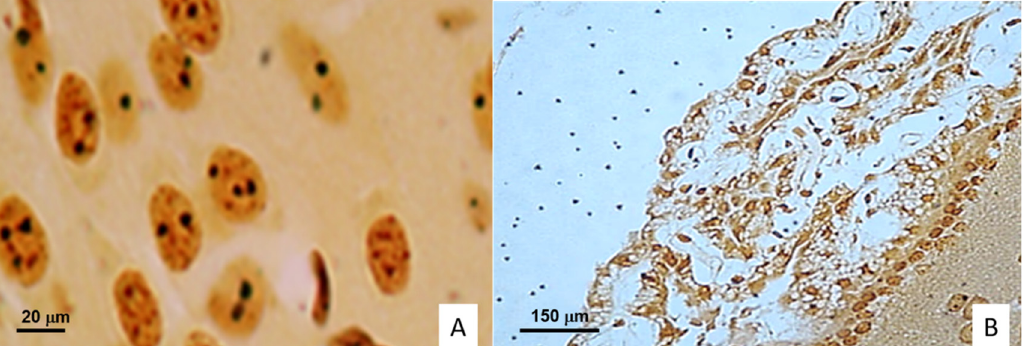
Figure 3. Histological micrographs of encephalon from Balb/C mice infected with M. tuberculosis N15 (LAM3) strain. ( A ) Brain cortex neurons with nuclei retraction, loss of chromatin, nucleolus preservation, and evident AgNORs (400× magnification). ( B ) Ependymal cells of choroid plexus with inflammatory characteristics, cytoplasmic vacuolation, and architectural distortion. Bielschowsky stain at 40× magnification.